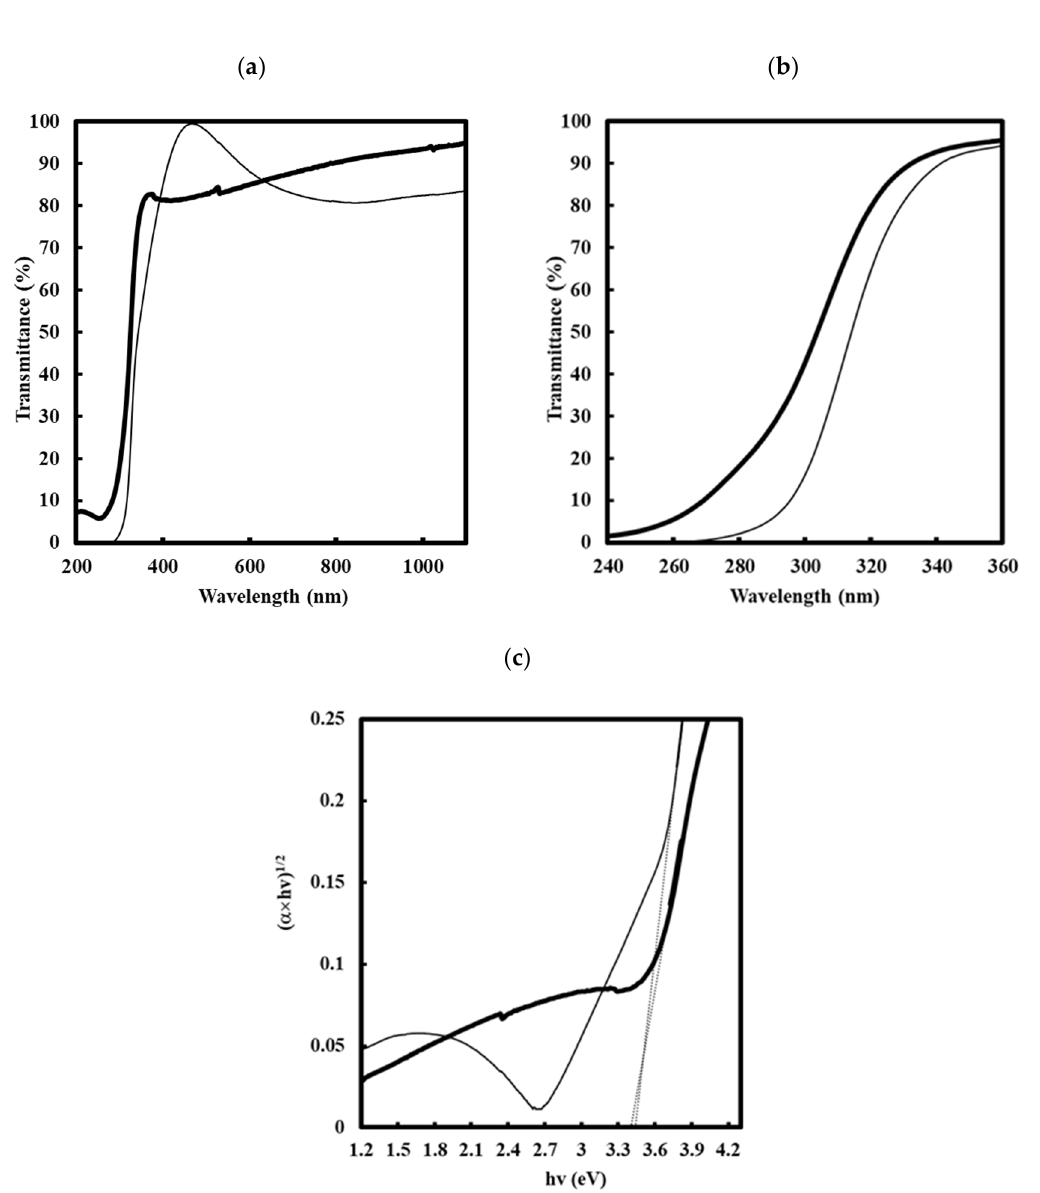
Figure 7. Transmittance spectra of the titania thin films: ( a ) QCNTESD and QSPIN, and the corresponding precursor films; ( b ) pre-QCNTESD and pre-QSPIN, along with the Tauc plots ( ... ) of the titania thin films; ( c ) QCNTESD and QSPIN. The lines represent the spectra of thin films prepared via the ESD ( – ) and spin-coating processes (—). Table 4. Refractive index and optical bandgap of the heat-treated thin films on the quartz glass substrate prepared via the ESD and spin-coating processes, QCNTESD and QSPIN. The bandgap was obtained based on the assumption of the indirect